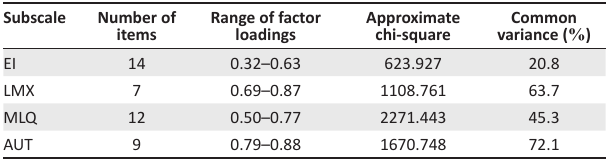
TABLE 3: Sample adequacy for performing exploratory factor analysis. Subscale